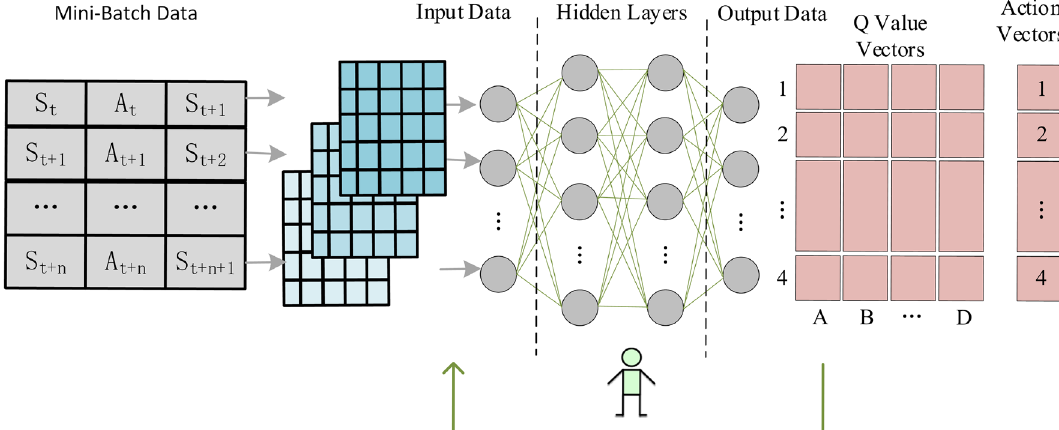
Figure 5. Schematic diagram of DRL model